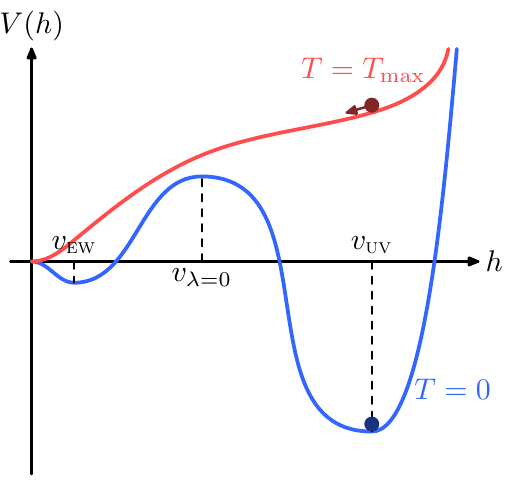
Figure 1 . Higgs potential at zero temperature (blue line) and at high temperature during the reheating phase (red line). The Higgs (cid:12)eld sits in the high energy minimum v uv during in(cid:13)ation, and then returns back to the electroweak vacuum during the thermal phase of reheating, when thermal corrections to the Higgs potential lift the minimum v uv . In reality, the (free) energy of the Higgs decreases for j h j < T , and the thermal potential can be (cid:12)t by a positive quadratic times exponential term, plus a negative o(cid:11)set that we did not show explicitly in this (cid:12)gure for better